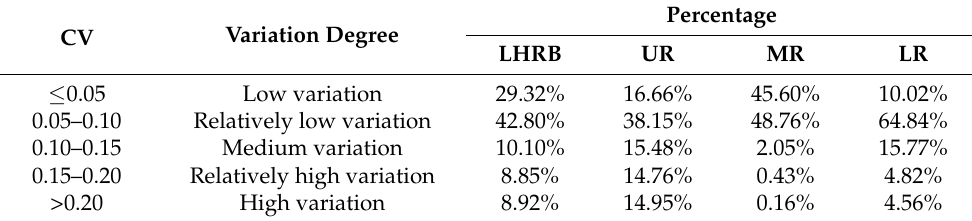
Figure 7. Spatial distribution of CV of EQ from 2001 to 2020. Table 1. Variation degree of EQ in different regions from 2001 to 2020.